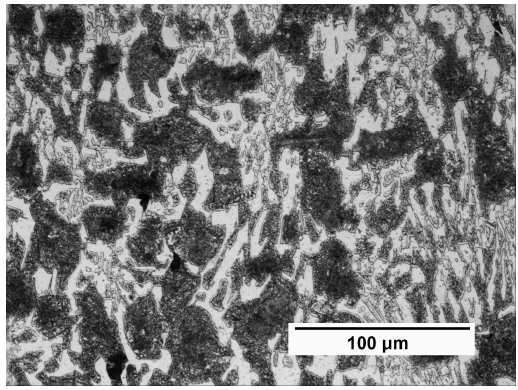
Figure 1. Microstructure obtained in the as-cast state. Optical microscope: ( a ) 500 magnifications; ( b ) 1000 magnifications.